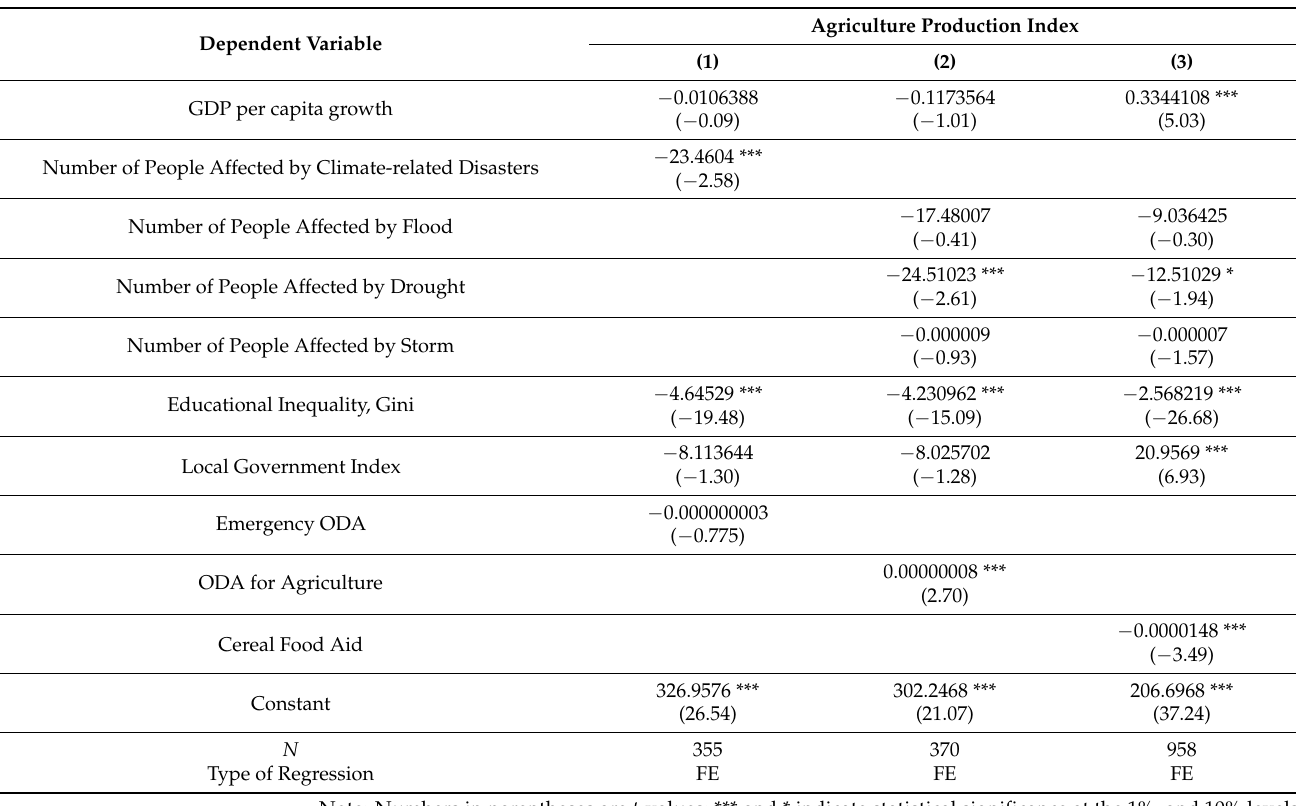
Table 4. Impact on Agricultural Production by Climate-related Disasters and